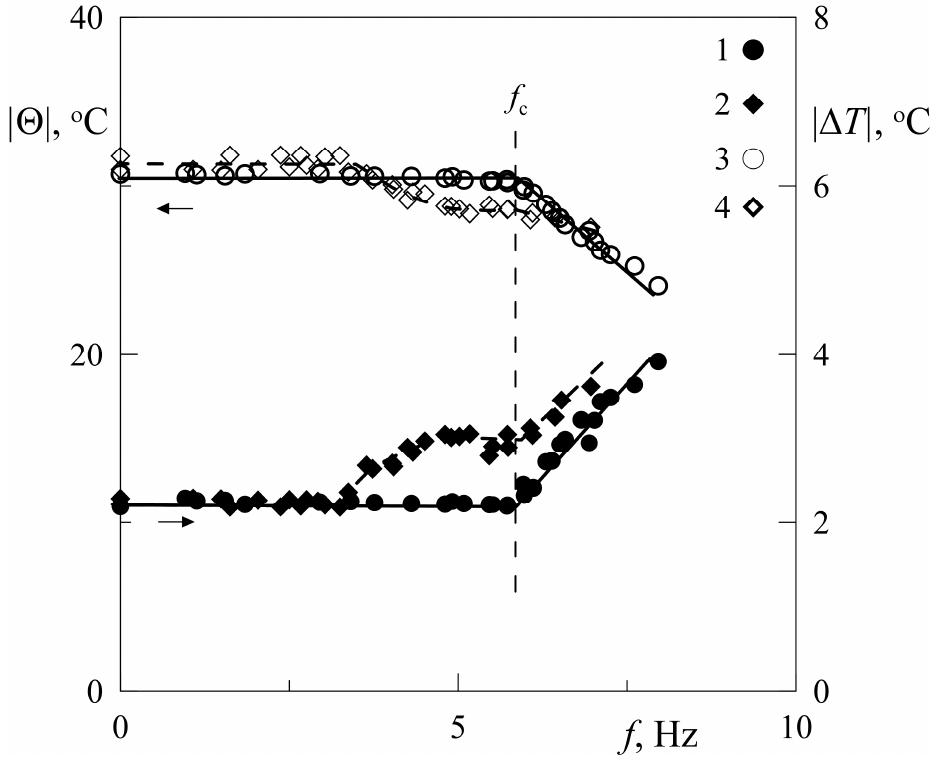
Figure 3. The dependence of the temperature difference Θ at the layer boundaries and the temper- ature drop ∆ T on heat flux sensor on the vibration frequency f when using the different types of visualizer (points 1, 3 and 2, 4). The layer thickness h = 4.2 mm. To visualize the vibroconvective flows, the calliroscope particles with the density slightly exceeding the density of the liquid were used, the characteristic particle size equals 40 ± 5 µ m. Experiments with and without particles added [12] showed that this visualizer does not affect the excitation threshold of vibrational convection, as well as the heat